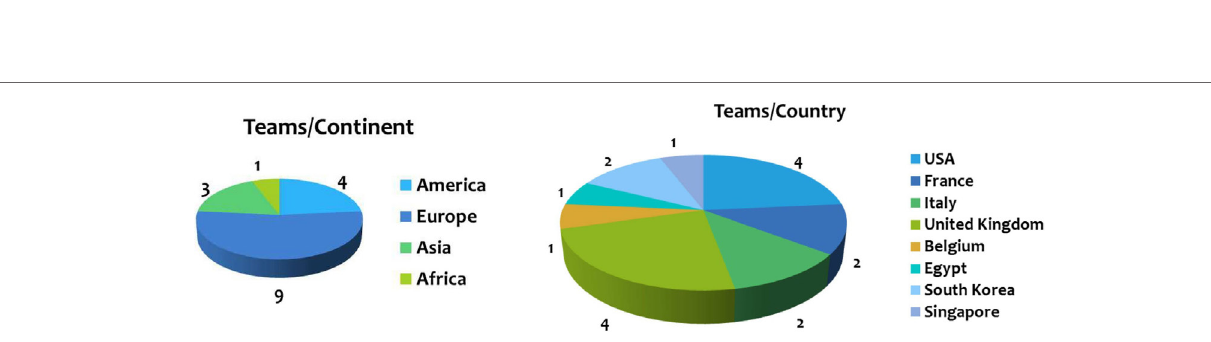
FIGURe 5 | the schedule of the challenge organization, with the principal phases and the number of entries each phase highlighted